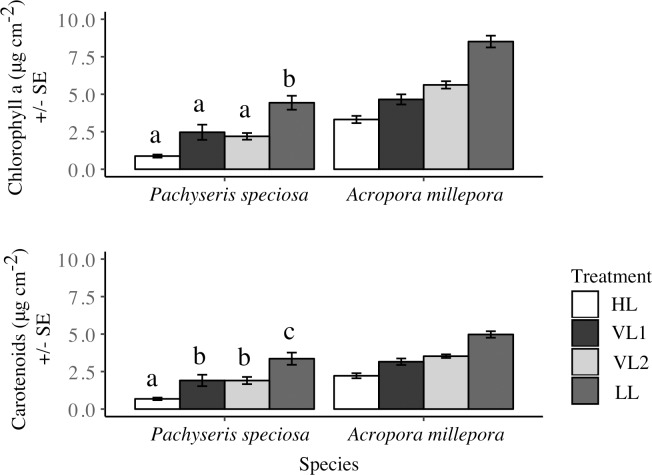
Effects of constant and variable light on pigment concentrations.Concentration of chlorophyll a (μg cm-2) and total carotenoids (μg cm-2) in Pachyseris speciosa (N = 5–6 nubbins/treatment) and Acropora millepora (N = 16 nubbins/treatment) under high DLI (white), low DLI (black), and variable DLI (VL1, light gray, and VL2, dark gray) treatments at the end of the 20-days experiment. Tukey HSD post-hoc results from one-way ANOVA comparison superimposed. Error bars represent standard error.